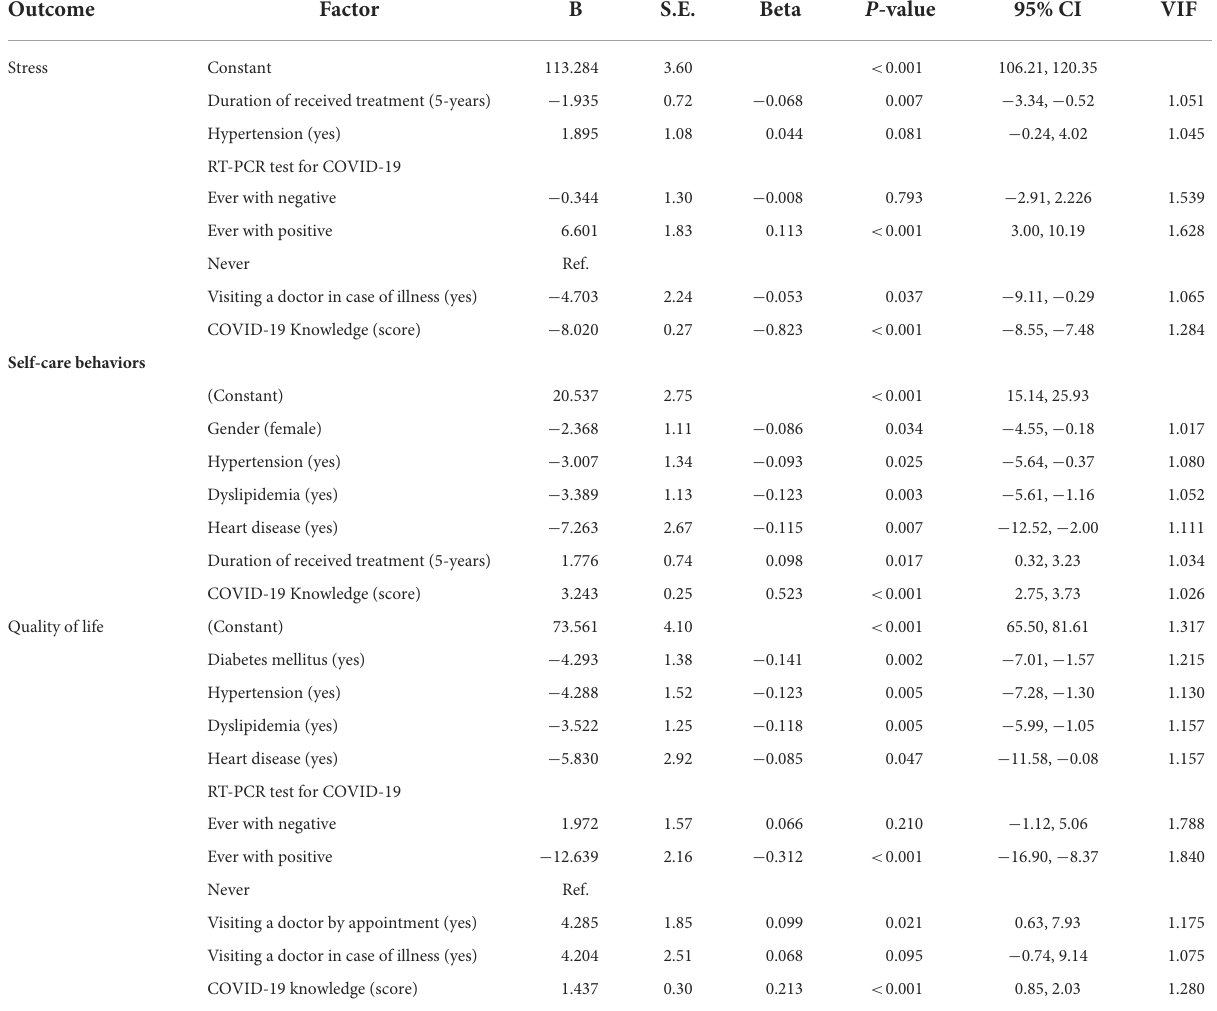
TABLE 3 Association between the COVID-19 knowledge influencing stress, self-care behaviors, and quality of life among elderly with NCD by multiple linear regression. Outcome Factor B Stress